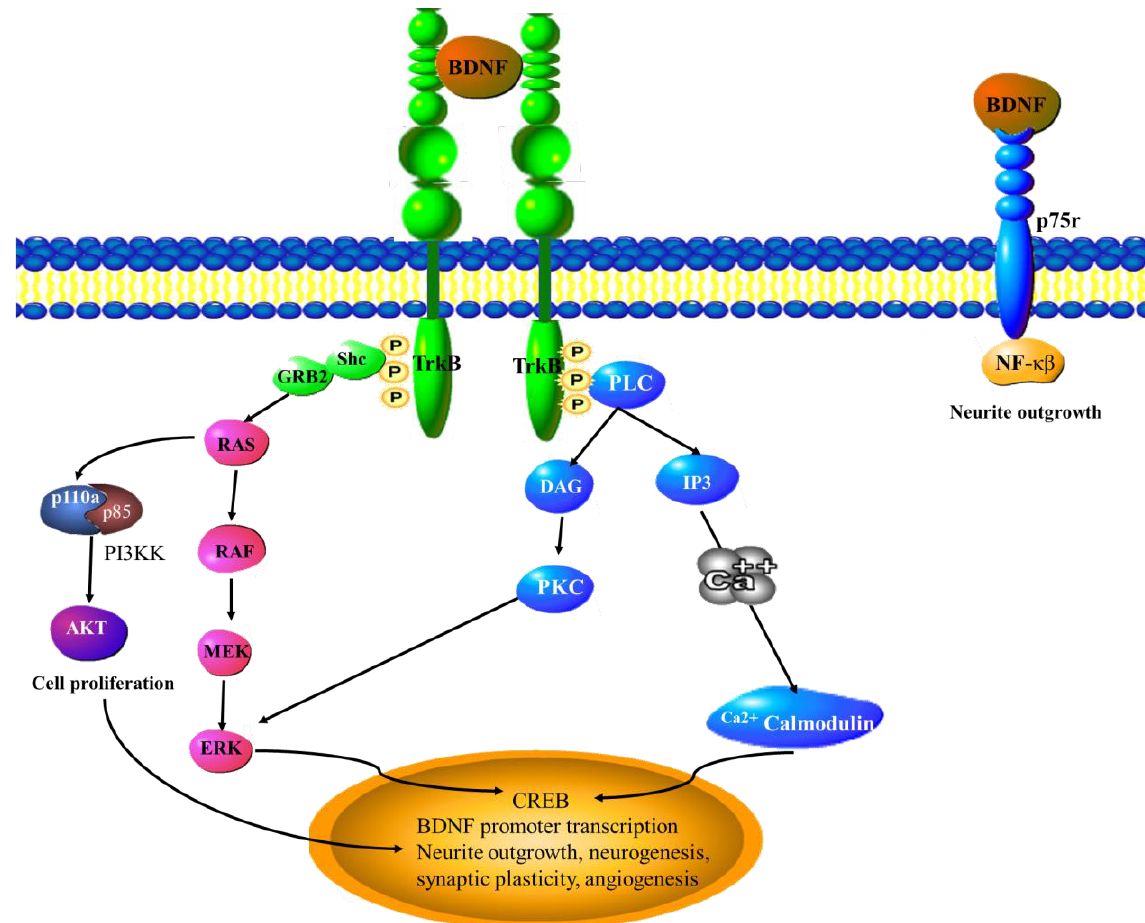
Figure 5. BDNF signaling pathways. Binding of BDNF to TrkB leads to the activation of MAPK, PI3K, and PLCγ pathways . The Shc adaptor protein recruits the growth-factor-receptor-bound pro- tein 2 (grb2) to form a complex with Ras. This initiates ERK, which then activates the CREB tran- scription factor. Binding of TrkB also activates the PI3K and MF- κβ signaling pathways. These path- ways play a role in neurotrophic functions (survival, growth, and differentiation) . The PLCγ path- way generates inositol-1, 4, 5-triphosphate (IP3) and diacylglycerol (DAG), resulting in Ca 2+ /CaMKI activation and the initiation of the transcription of genes that are pro-angiogenic and pro-neuro- genic. CREB — Cyclic AMP-responsive element-binding protein, ERK — extracellular signal-regu- lated kinase, GRB1/2 — Growth factor receptor-bound protein 1/2, MEK — Mitogen activated kinase, PIP-2/3 — phospholipase, PI3K — Phosphoinositide 3-kinase, PKC — Protein kinase C, PLC γ— Phos- phoinositide phospholipase C, Shp2 — Src homology region 2.